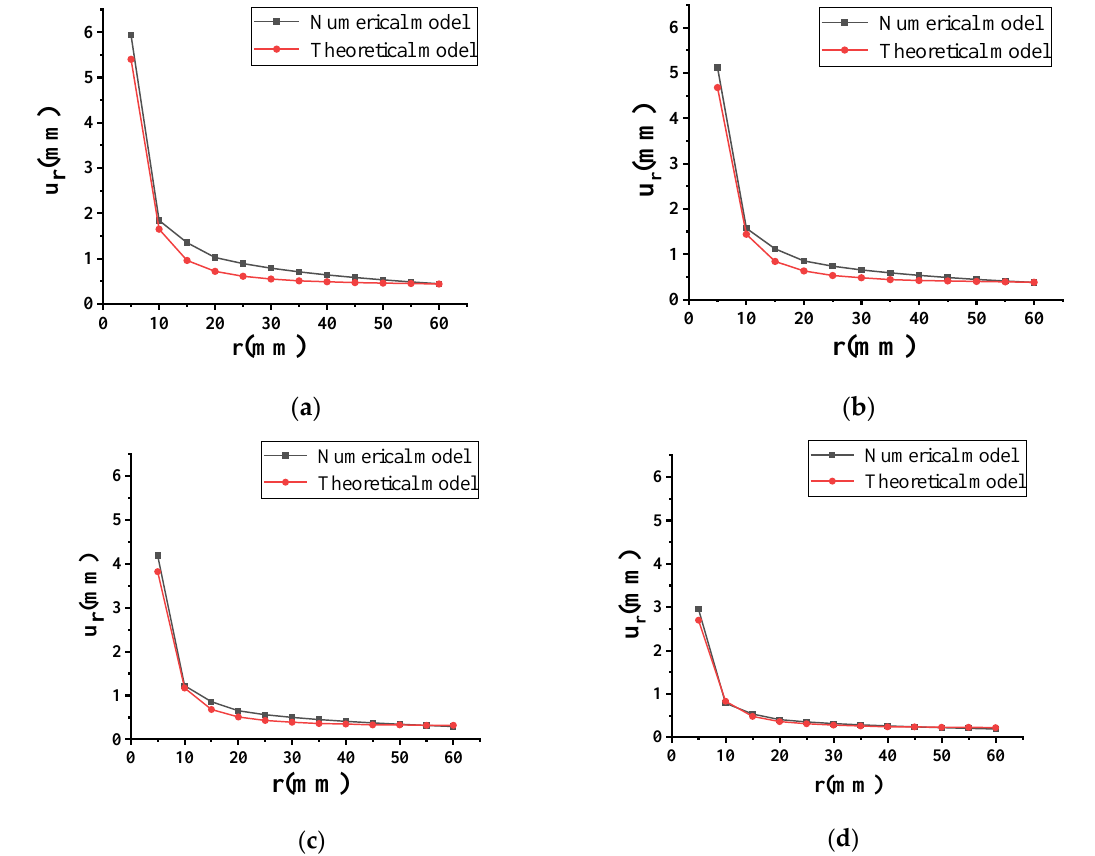
Figure 8. Relation diagram of u r of numerical and theoretical models with r under different θ . ( a ) θ = 0°, ( b ) θ = 30°, ( c ) θ = 45°, ( d ) θ =